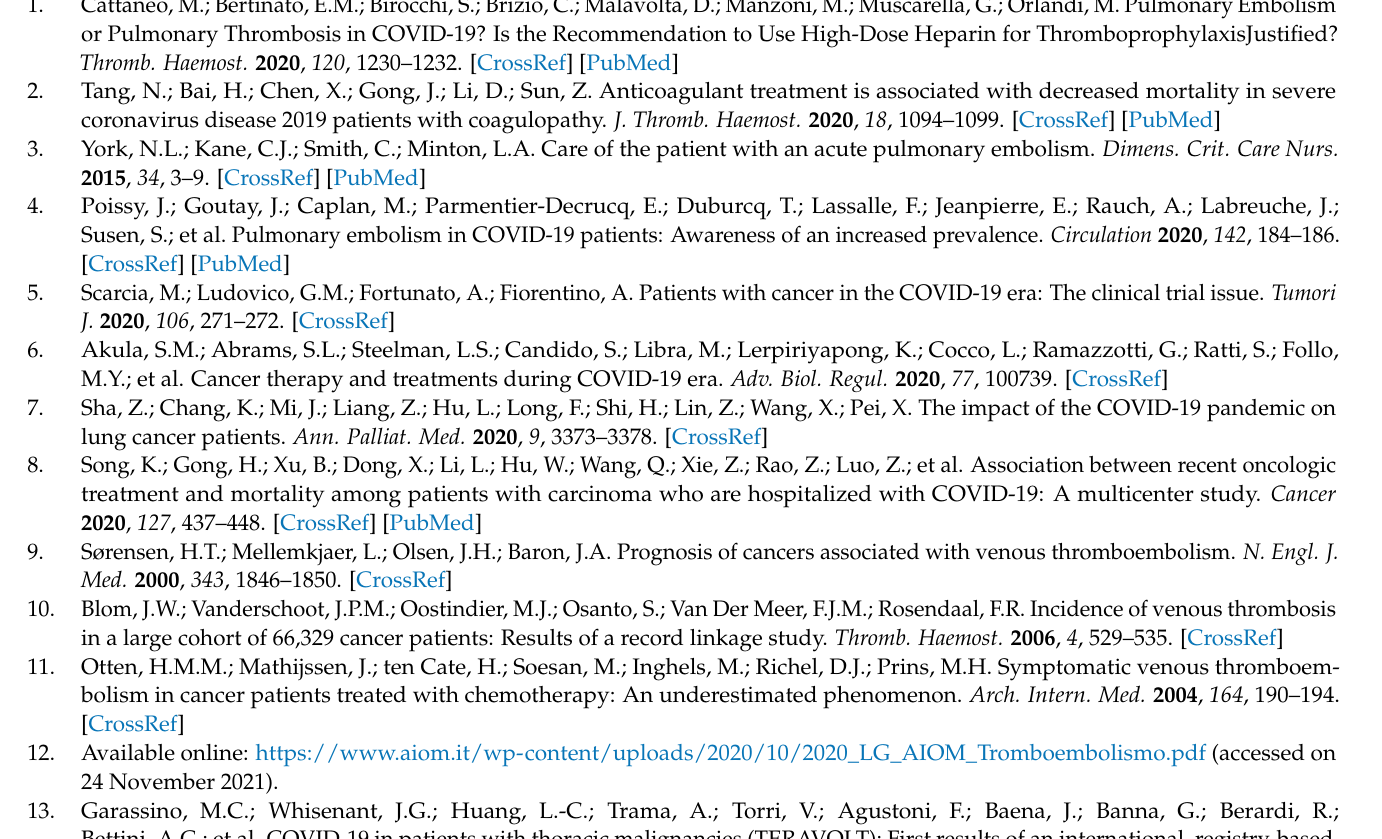
Table S1: List of 36 variables, full model, Table S2: List of 19 variables, reduced model, Table S3: Metrics used to measure the